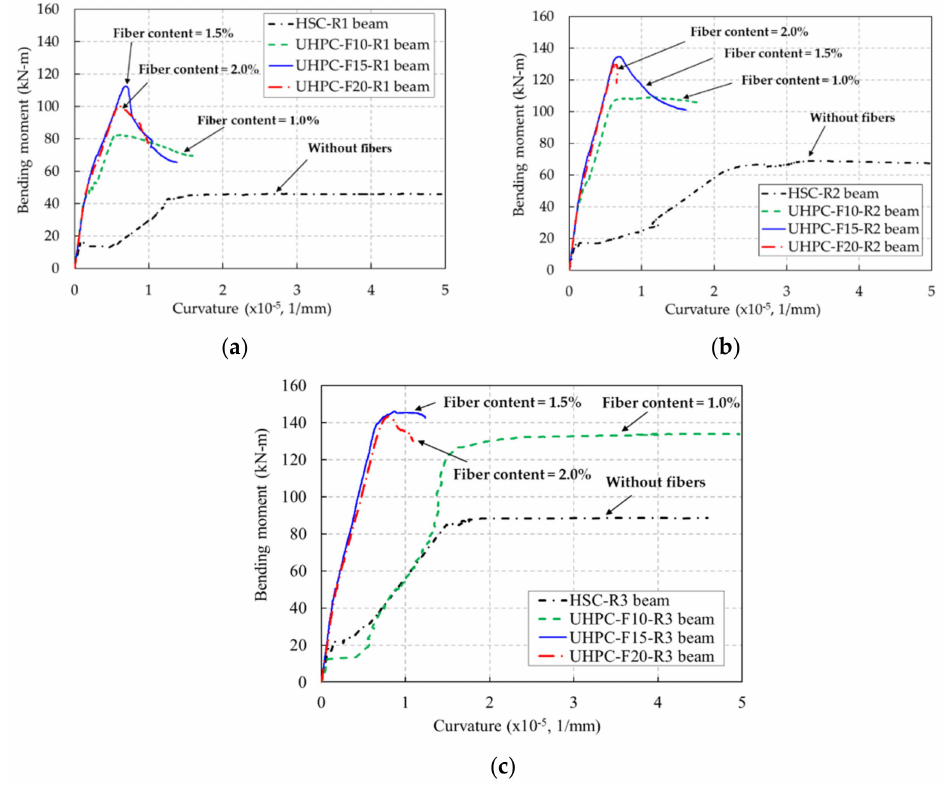
Figure 18. Moment-curvature curves of the UHPC and HSC beams. ( a ) R1 series beams (rebar ratio of 0.79%), ( b ) R2 series beams (rebar ratio of 1.18%), ( c ) R2 series beams (rebar ratio of